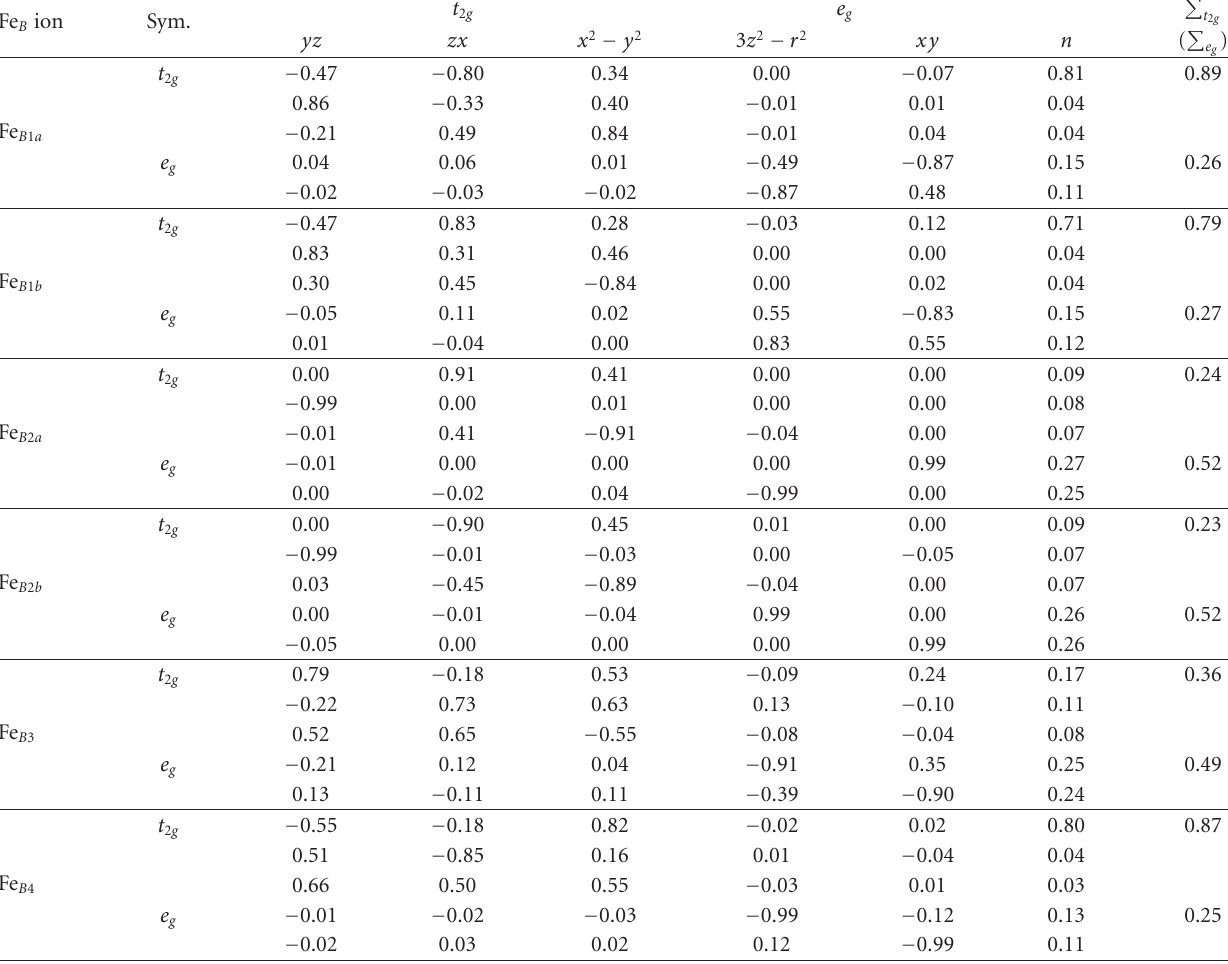
Table 1: 3 d orbital contribution to the formation of Fe B minority spin states with occupancy n evaluated by diagonalization of the occupation matrix [155]. Although one of the t 2 g ↓ states of B 1 and B 4 sites is almost occupied with n ≥ 0 . 7 e the t 2 g minority spin occupancies of B 2 and B 3 Fe 3+ cations are less than 0 . 1 e . The occupied t 2 g ↓ states of B 1 and B 4 Fe 2+ cations are predominantly of d xz ± d yz and d x 2 − y 2 characters, respectively. The sum of t 2 g ( e g ) occupations is given in the last column.